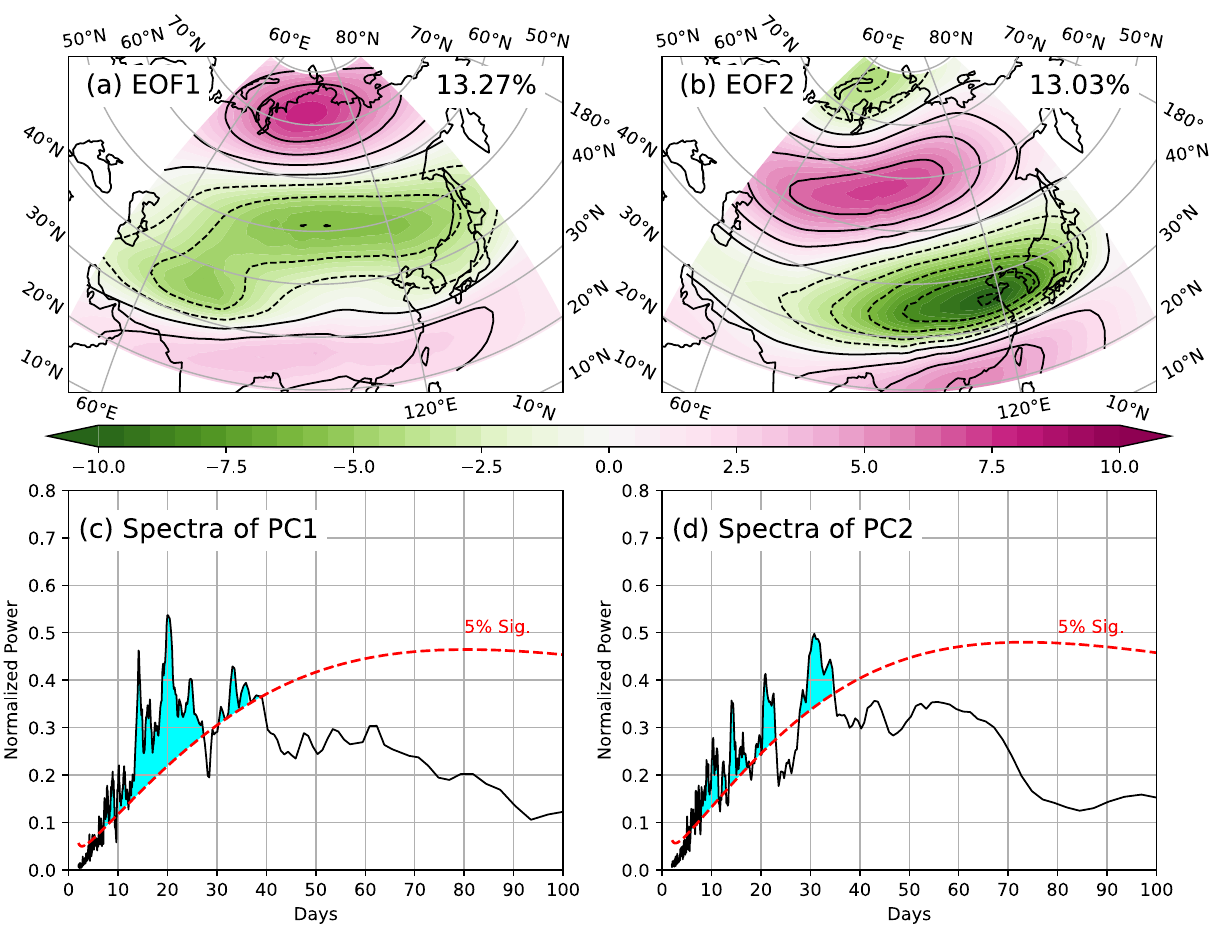
Figure 1. First two EOFs (panels a and b ) of the daily 1.5° × 1.5° U ERA at 200 hPa during boreal winter. Before the EOF, the seasonal cycle has been removed. The first EOF (EOF1) explains 13.27% of the total variance, and the second (EOF2) explains 13.03%. EOF is conducted over the region of 49.5–148.5°E and 19.5–79.5°N (shaded area). The two panels share the same color bar. Power spectra (black curve) for the two PCs of the first two EOFs (JET1&2) are shown in panels c and d, respectively. The red-dash line shows the 5% significant level based on the Markov red noise, and the significant power spectra are shaded in blue. The x-axis is the period, and the y-axis is the normalized power